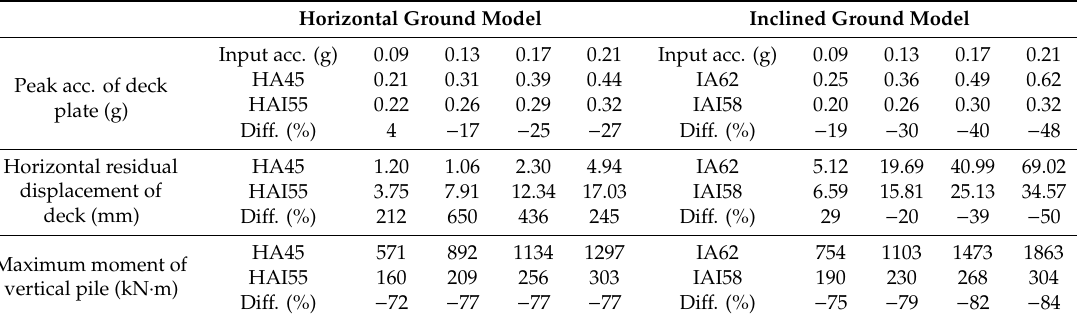
Table 5. Di ff erence in system response with and without the batter